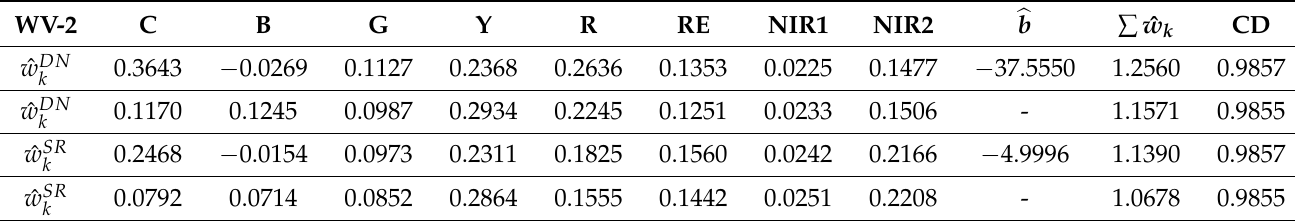
Table 4. MMSE coefficients of the multivariate linear regression between interpolated MS bands and lowpass-filtered Pan, both in either DN or SR format, for the WorldView-2 Sydney image. The bias, (cid:98) b , is either set equal to zero or left as a further variable to optimize.